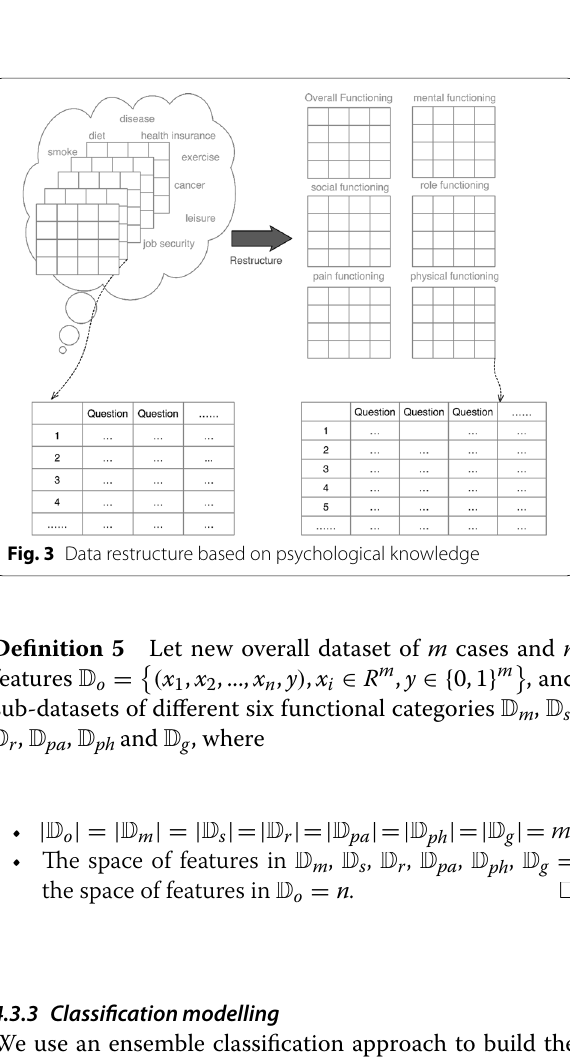
(cid:30) , and D D s , m ,